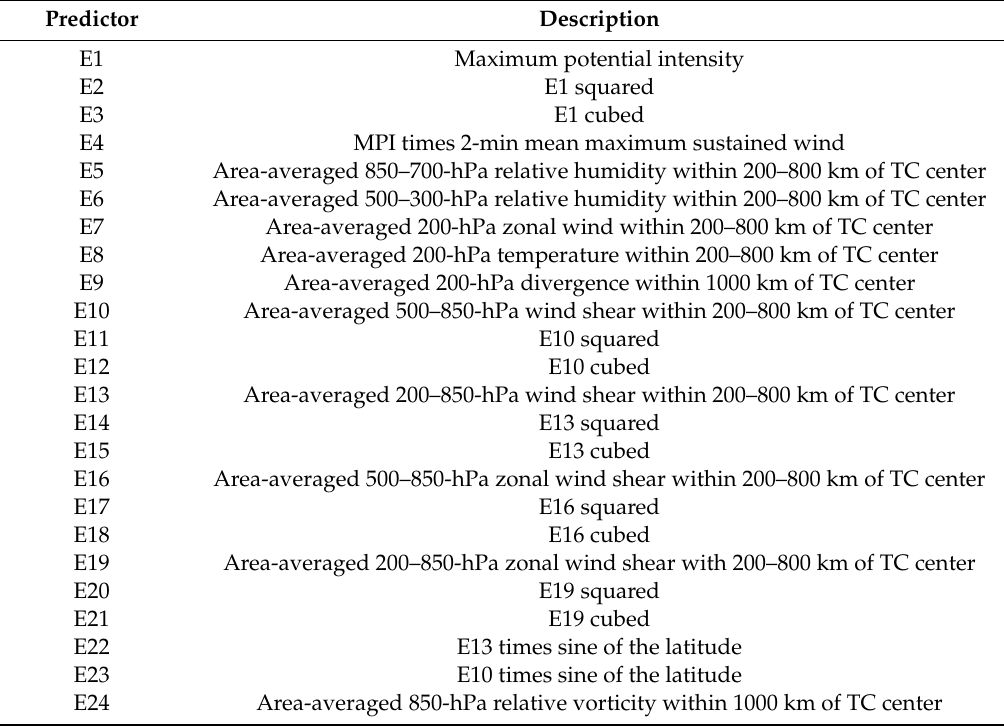
Table 5. Detailed description of the 24 environmental factors.